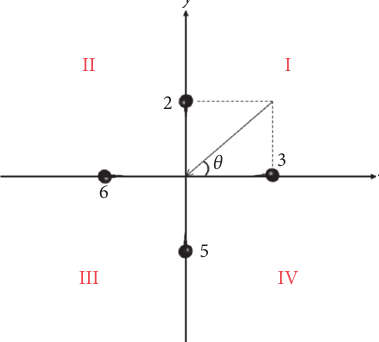
Figure 9: Estimation of azimuth angle for spatial direction